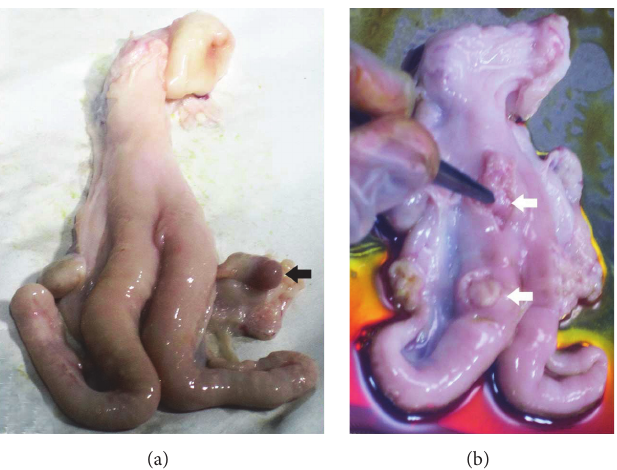
Figure 1: Uteri of goats (a) in breeding stage with corpus luteum (black arrow) and (b) in anestrus stage. The locations of sampling of endometrial tissues are shown by white arrows on body and horn of the